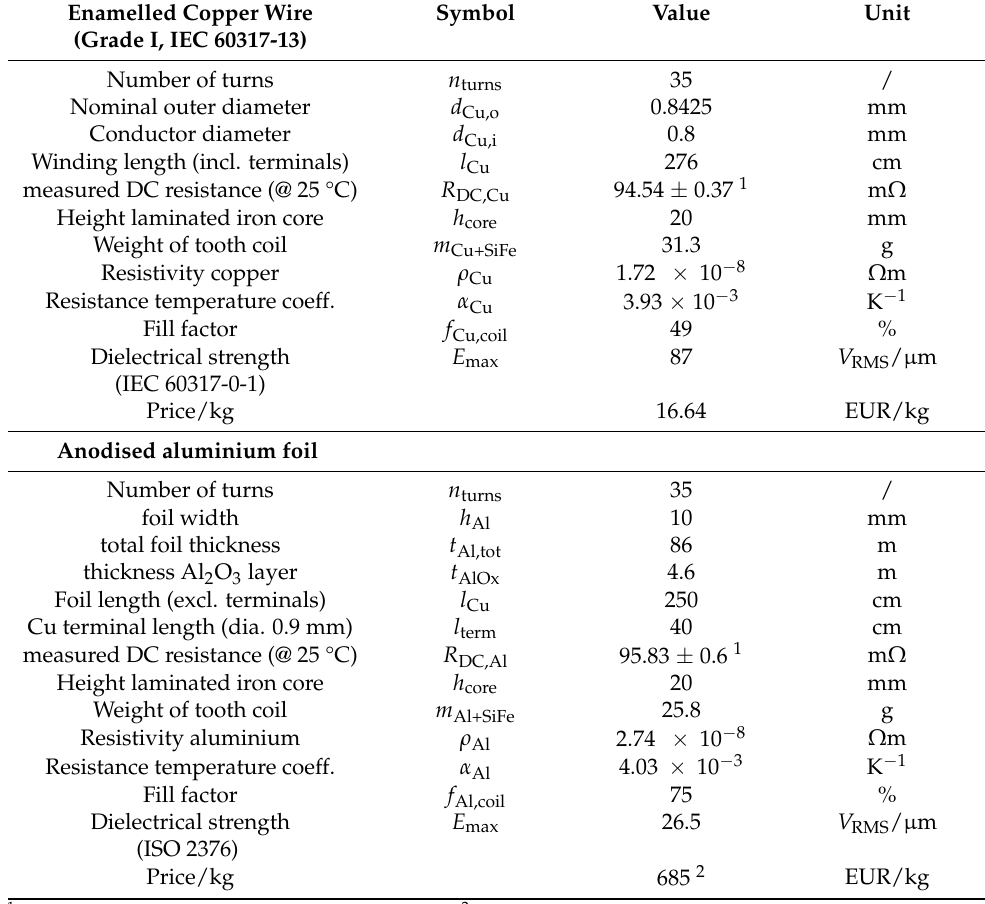
Table 3. Specifications of the prototype tooth coil.